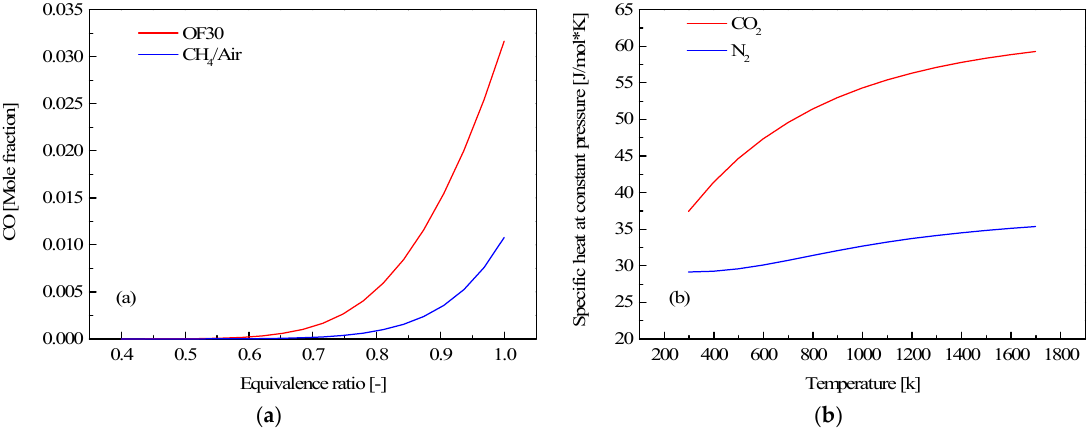
Figure 6. Two properties which can contribute to the difference in adiabatic flame temperature. ( a ) CO emission in an equilibrium state with an inlet temperature of 431.15 K; ( b ) Specific heat of CO 2 and N 2 .